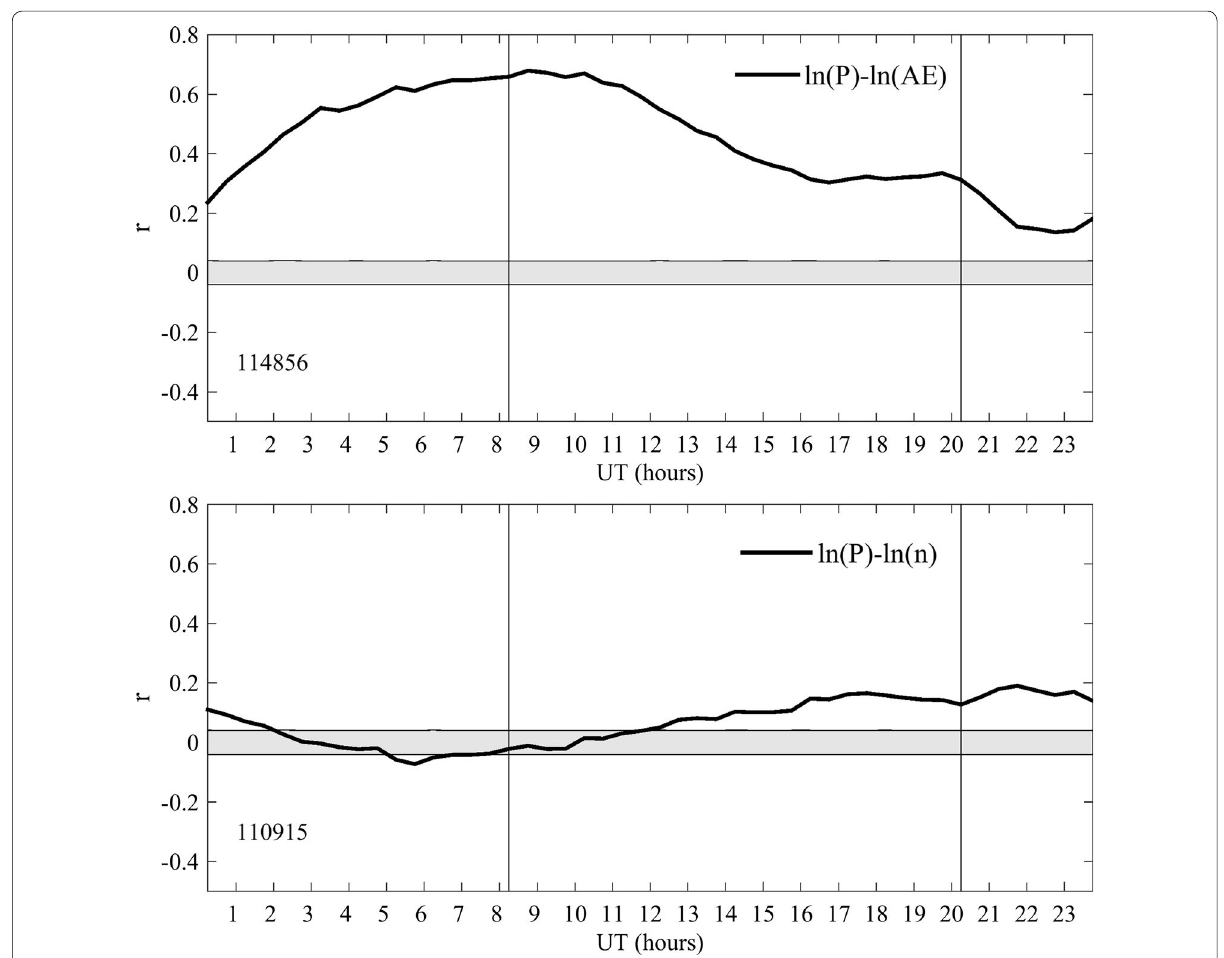
Fig. 10 Correlation analysis. The diurnal variation in correlation between ln( P ) and ln( AE ) (upper panel) and between ln( P ) and ln( n SW ) (bottom panel). The shaded areas indicate the 95% confidence intervals. In each panel the number of selected time intervals is shown, and the vertical lines at approximately 08 UT and 20 UT indicate the magnetic midnight and noon,